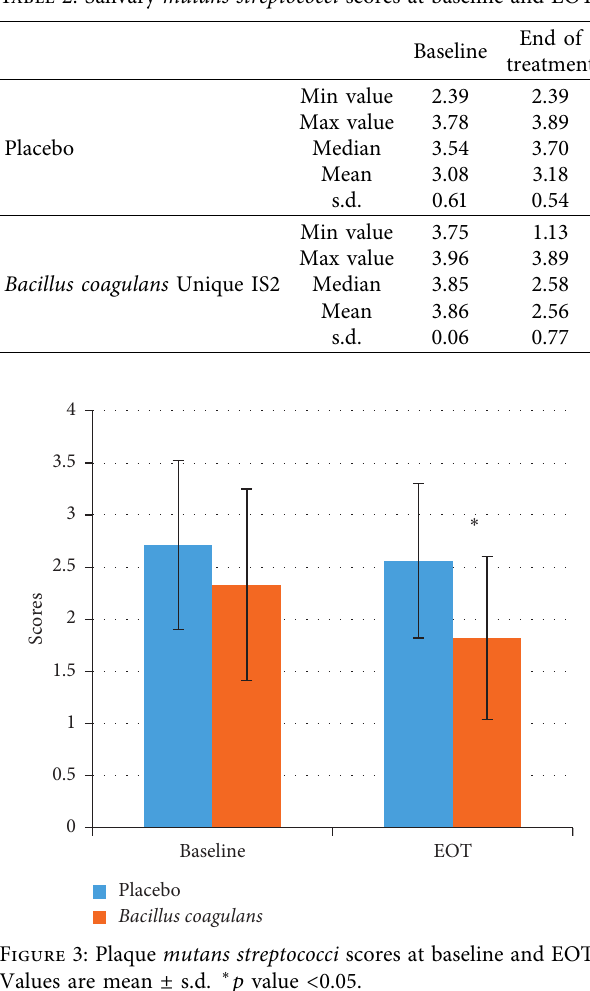
Figure 2: Salivary mutans streptococci scores at baseline and EOT. Values are mean ± s.d. ∗∗∗ p value < 0.001. Table 2: Salivary mutans streptococci scores at baseline and EOT.